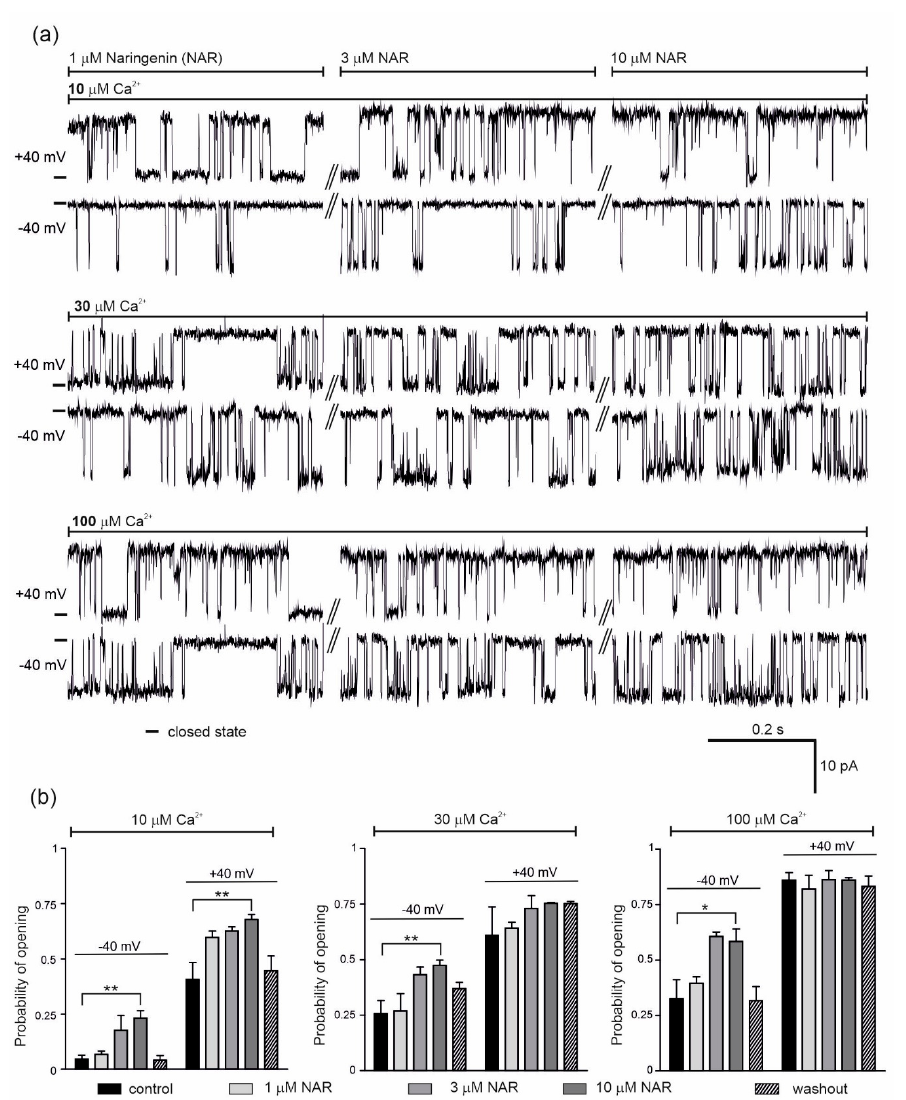
Figure 2. E ff ect of naringenin on the endothelial mitoBK Ca channel activity. ( a ) Representative single-channel recordings of the mitoBK Ca at − 40 and + 40 mV. Experiments were performed in a symmetric 150 / 150 KCl with additions as indicated. ( b ) The mitoBK Ca probability of opening at –40 and + 40 mV in the presence of naringenin (1, 3 and 10 µ M) at di ff erent Ca 2 + concentrations, as indicated. The data are presented as the means ± SD ( n = 5). ** p < 0.01, * p < 0.05.